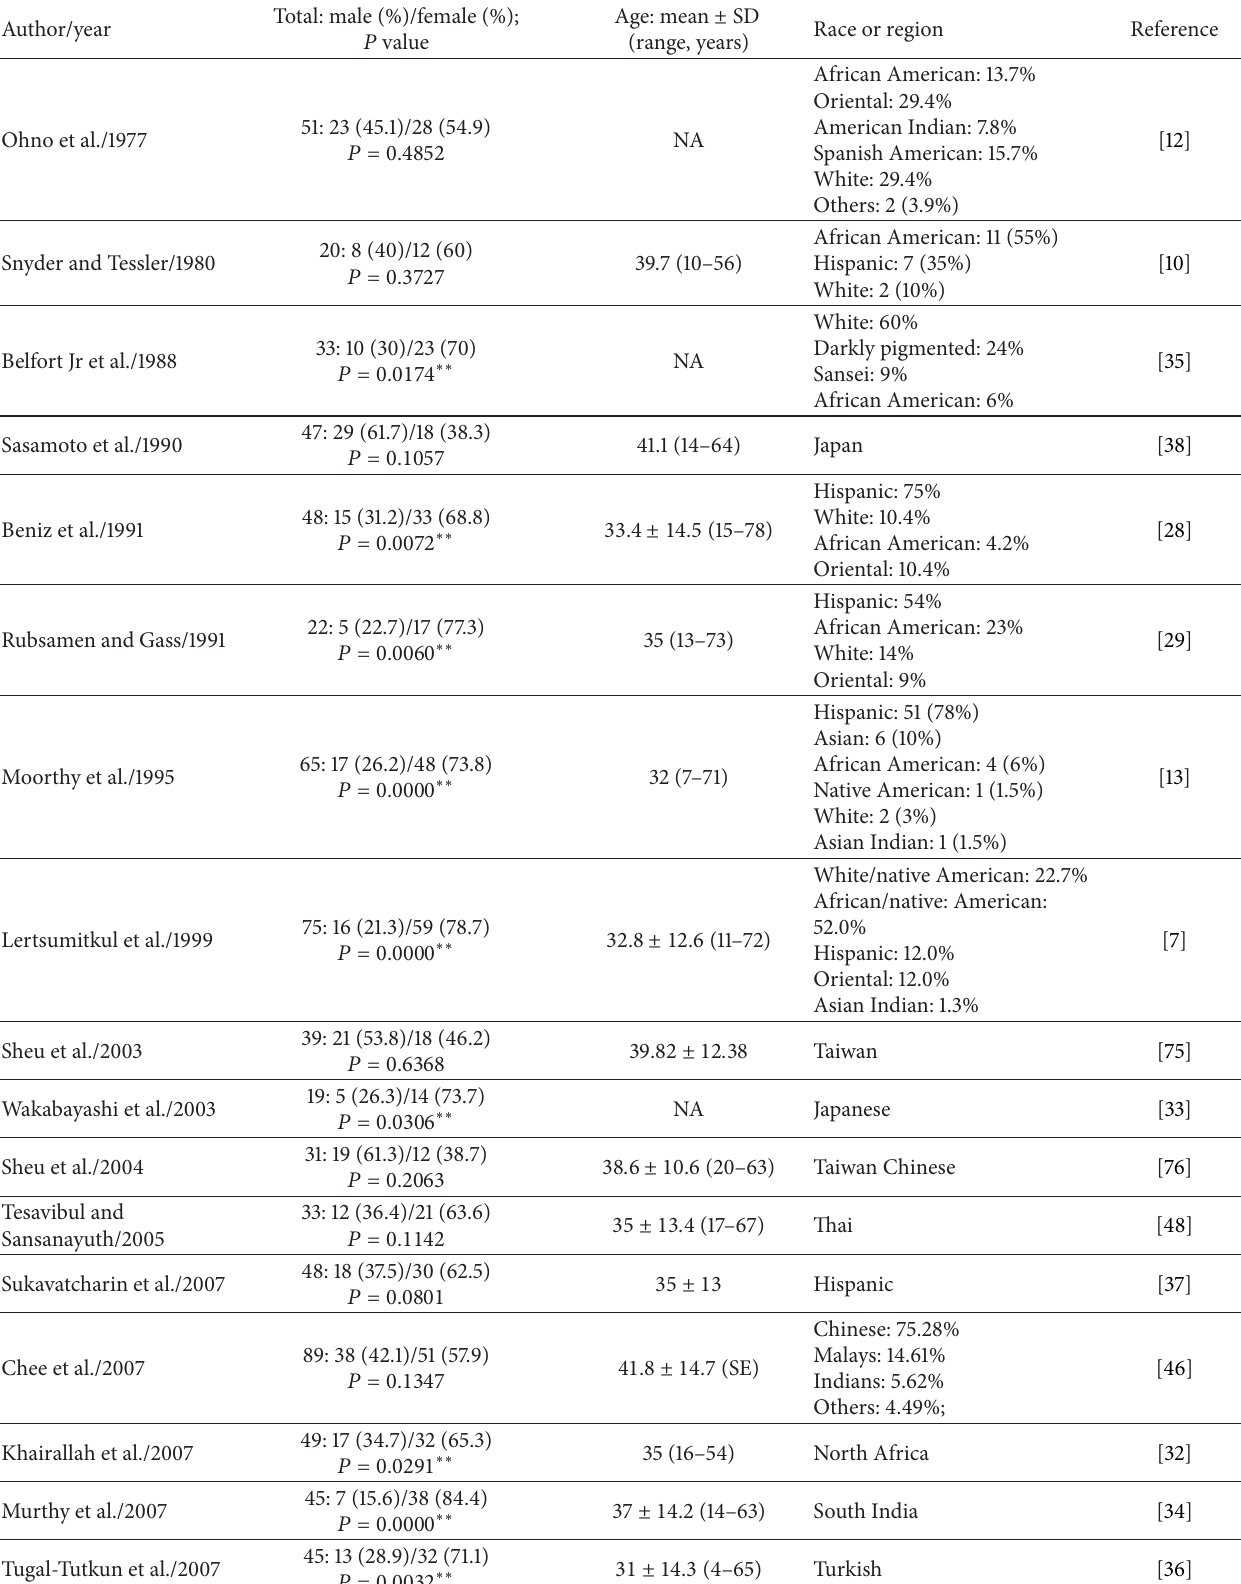
Table 1: Demographic differences of Vogt-Koyanagi-Harada disease (VKH) in the